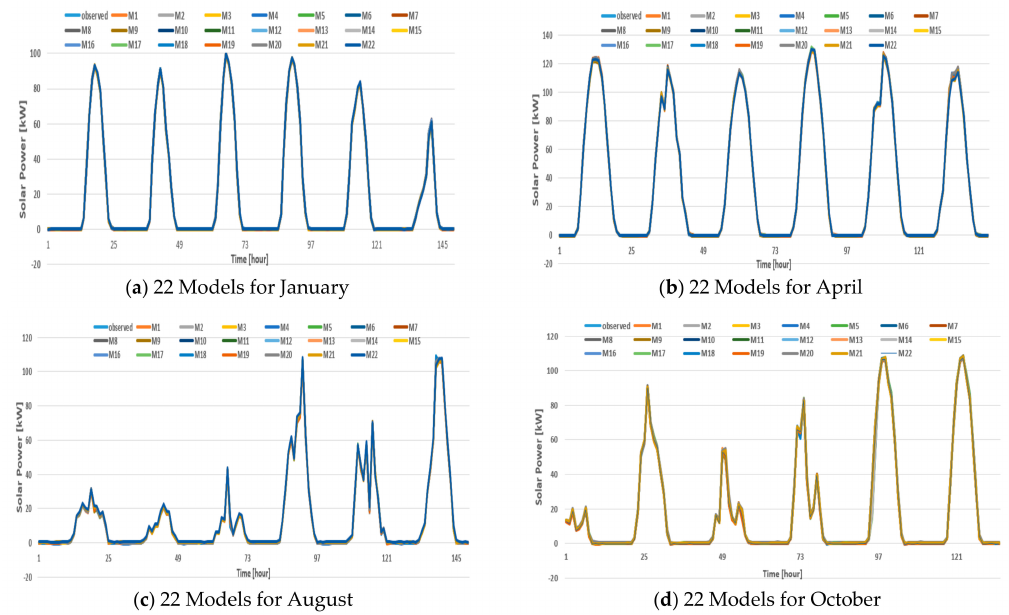
Figure 10. Comparison among the 22 models for the proposed LSTM by month.